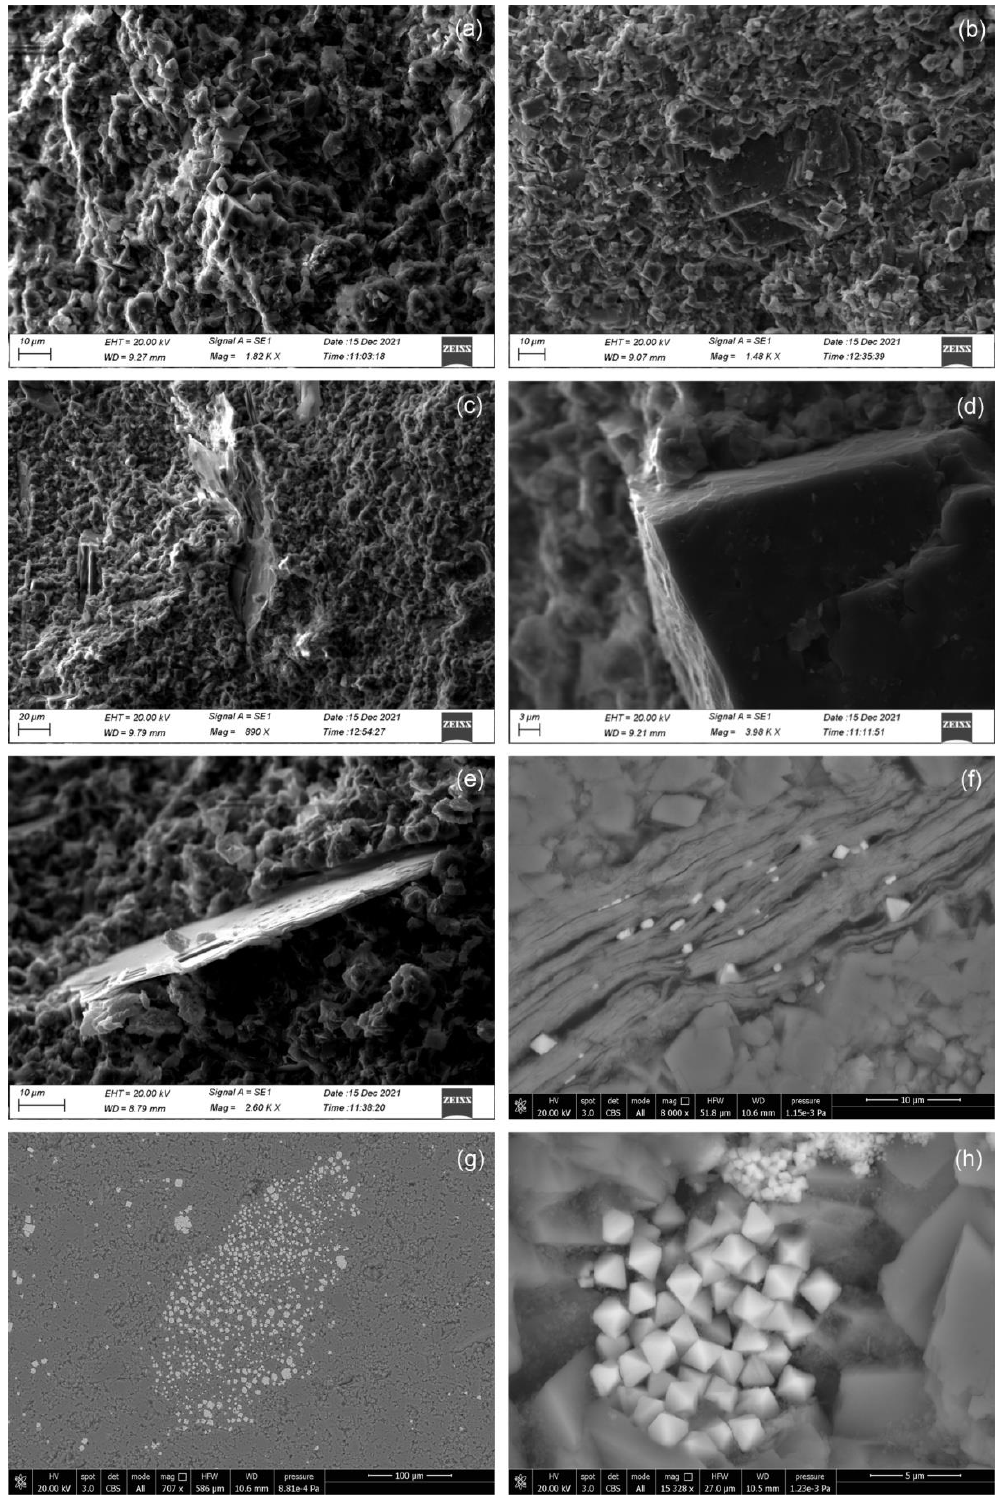
Figure 6. Scanning electronic microscope microphotos showing dolomite and phyllosilicates: ( a ) structure 5a; ( b ) structure 42, rim; ( c ) structure 20; ( d ) structure 5a; ( e ) structure 5b; ( f – h ) Back-scattered electron (BSE) images of structure 17 showing ( f ) detail of phyllosilicates; ( g,h ) details of pyrite microcrystals embedded into dolomite microcrystals.